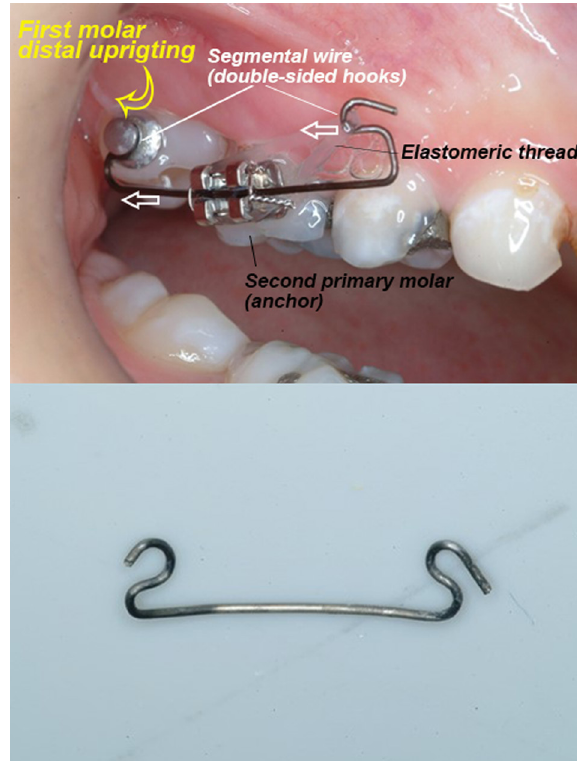
Figure 1. Illustration of the segmental wire with double-sided hooks and force application to the mesially angulated maxillary first molar for distal uprighting ( yellow arrow